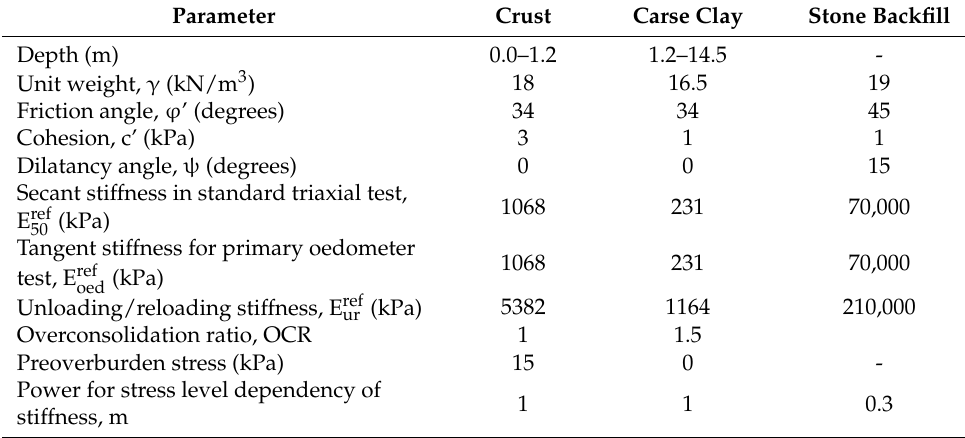
Table 3. Material parameters